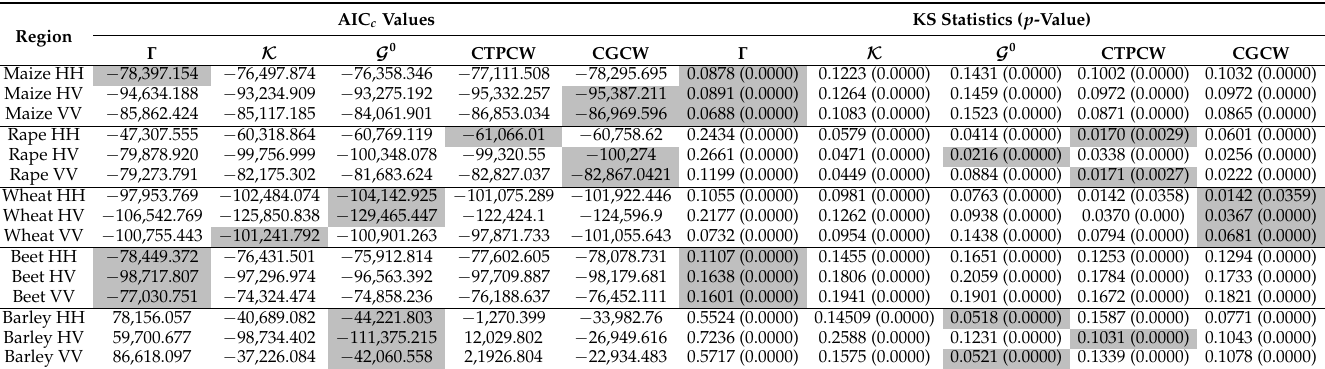
Table 7. Results of fitting intensities on intensities of AgriSAR PolSAR data for L fixed.